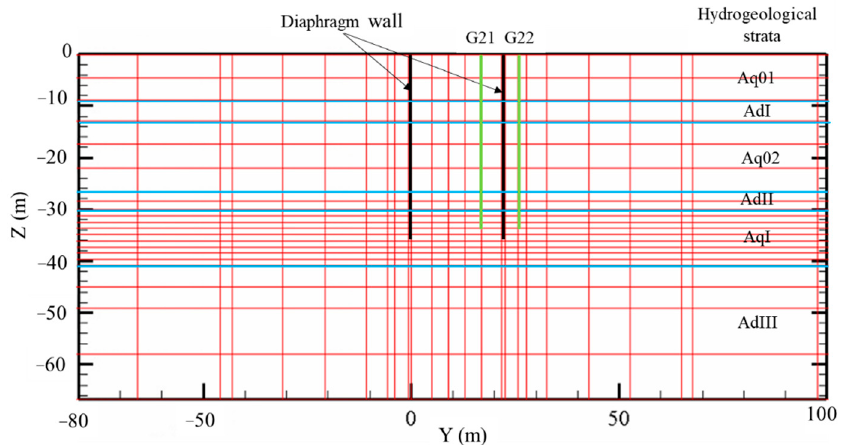
Figure 6. Profile of section II-II.